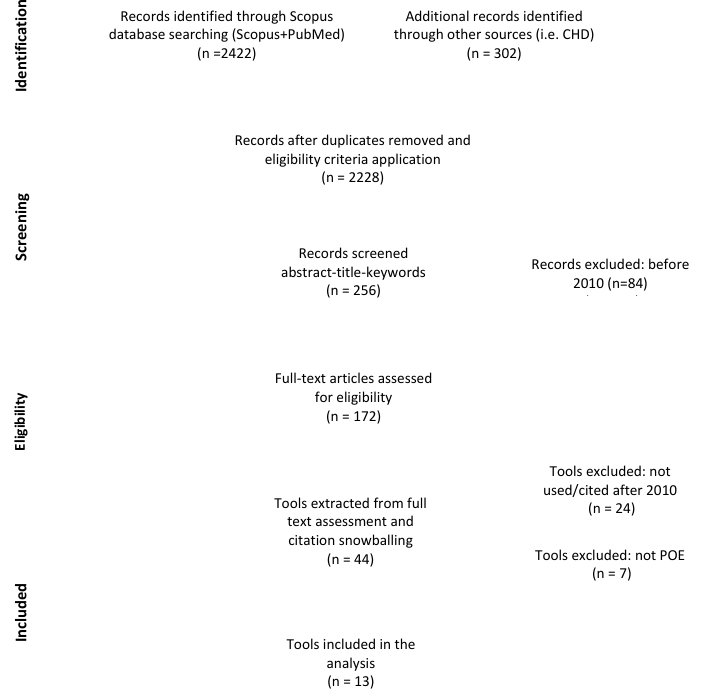
Figure 3. The Prisma Flow Diagram shows the process followed for the identification of the 13 POE tools included in the analysis.